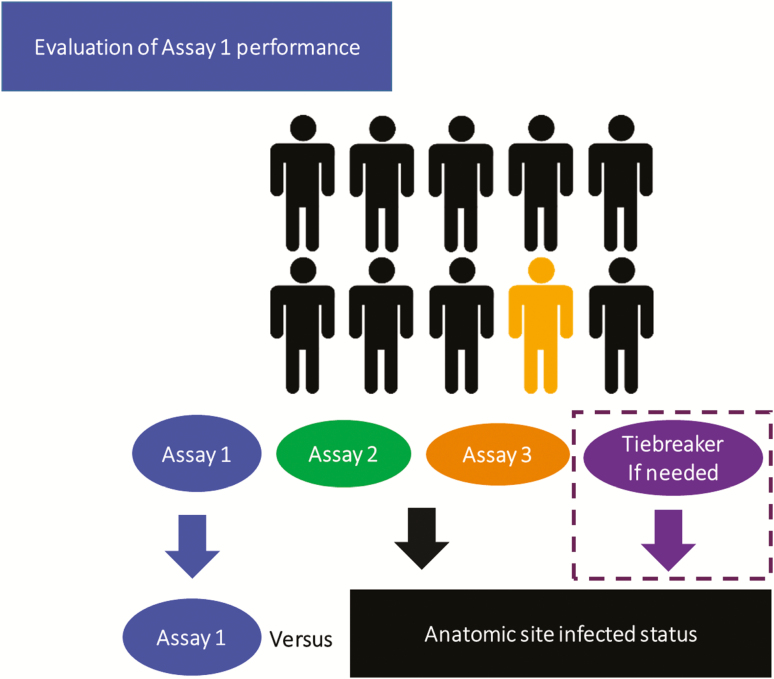
Schematic of the Master Protocol concept from the prototype perspective of evaluation of diagnostic performance of assay 1. The results from assays 2 and 3 determine the anatomic site infected status for assay 1. Tiebreaker tests are performed only if indicated. Evaluation of assay 2 and 3 would proceed utilizing a similar approach. Individuals depicted in black and yellow represent participants without and with infection, respectively.